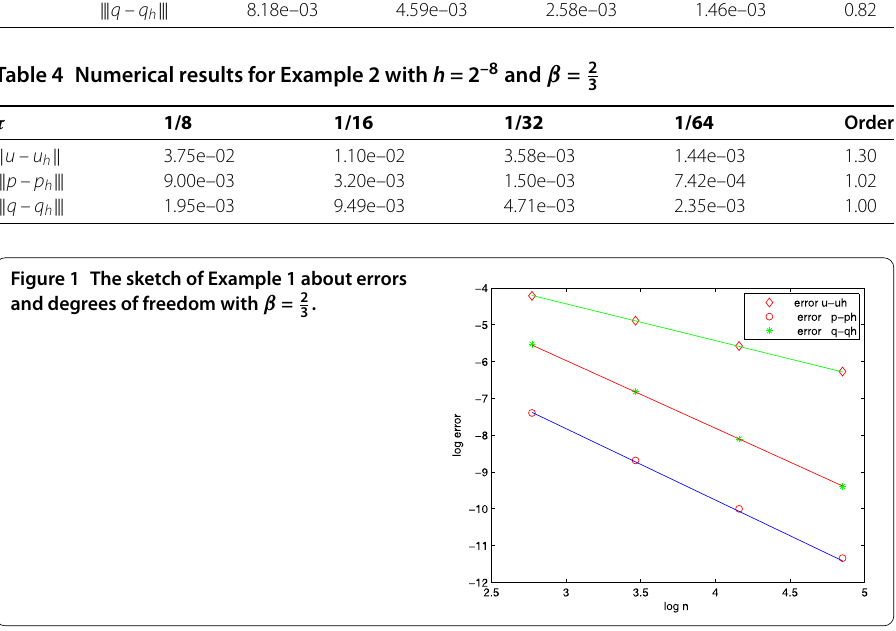
Table 4 Numerical results for Example 2 with h = 2 –8 and β = 2